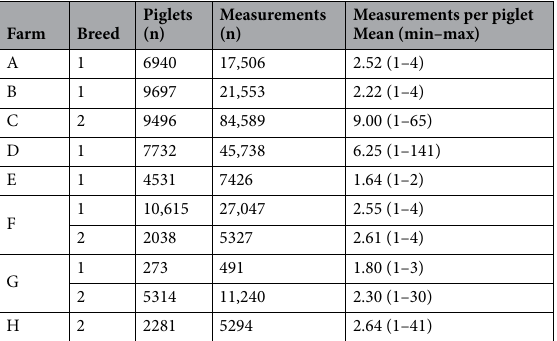
Table 1. Number of measurements per piglet for each farm and breed.